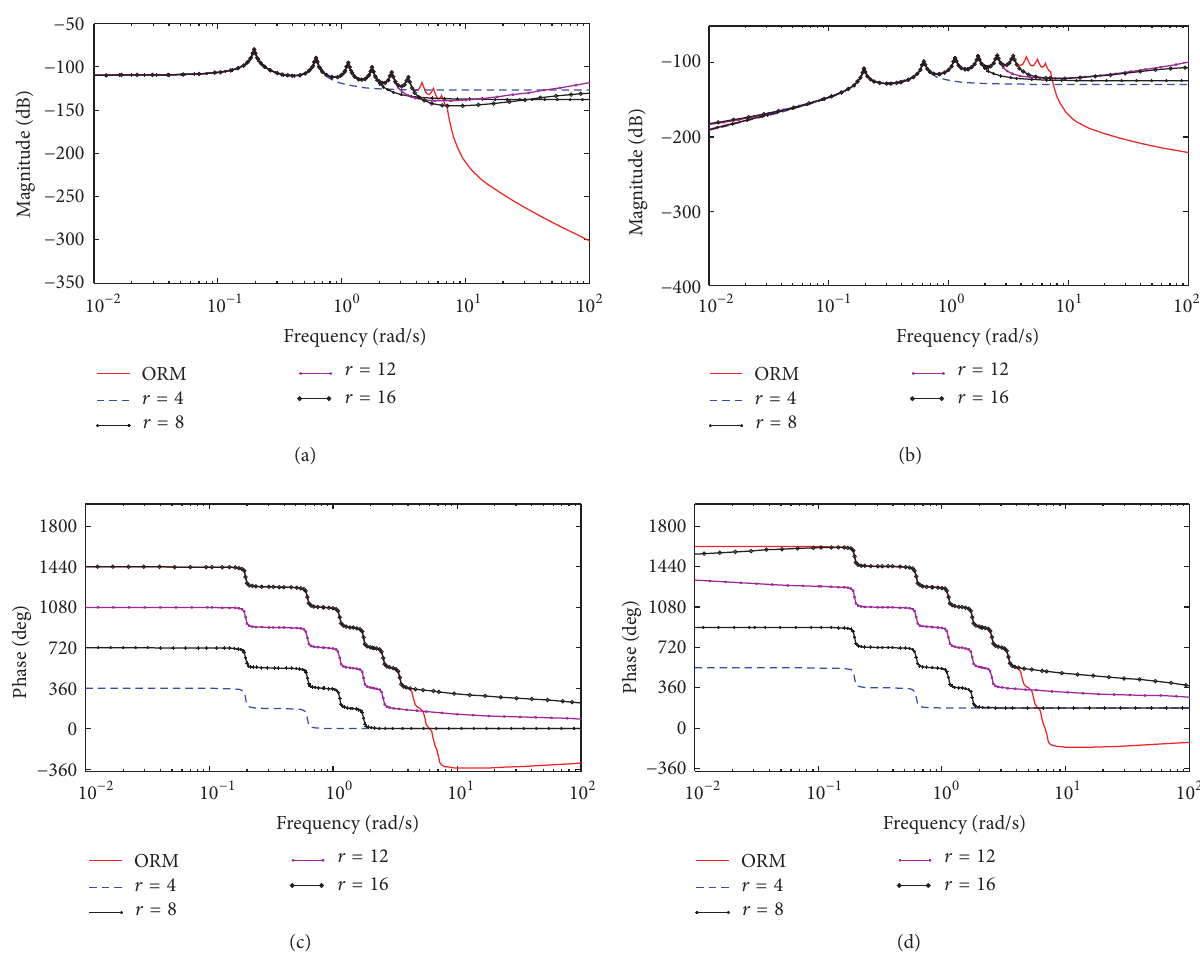
Figure 4: Comparison of transfer functions of the reduced-order model by improved BT method . (a) Magnitude and (c) phase of the displacement transfer functions. (b) Magnitude and (d) phase of the acceleration transfer functions.